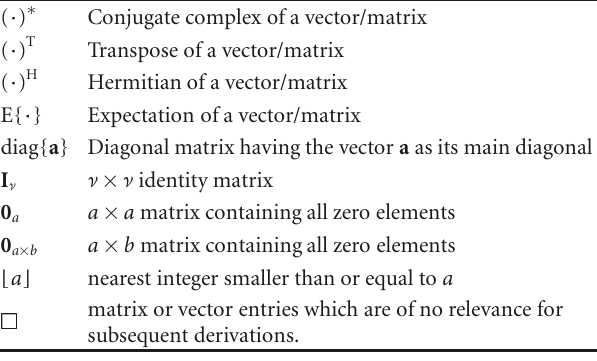
Table 1: Notations.